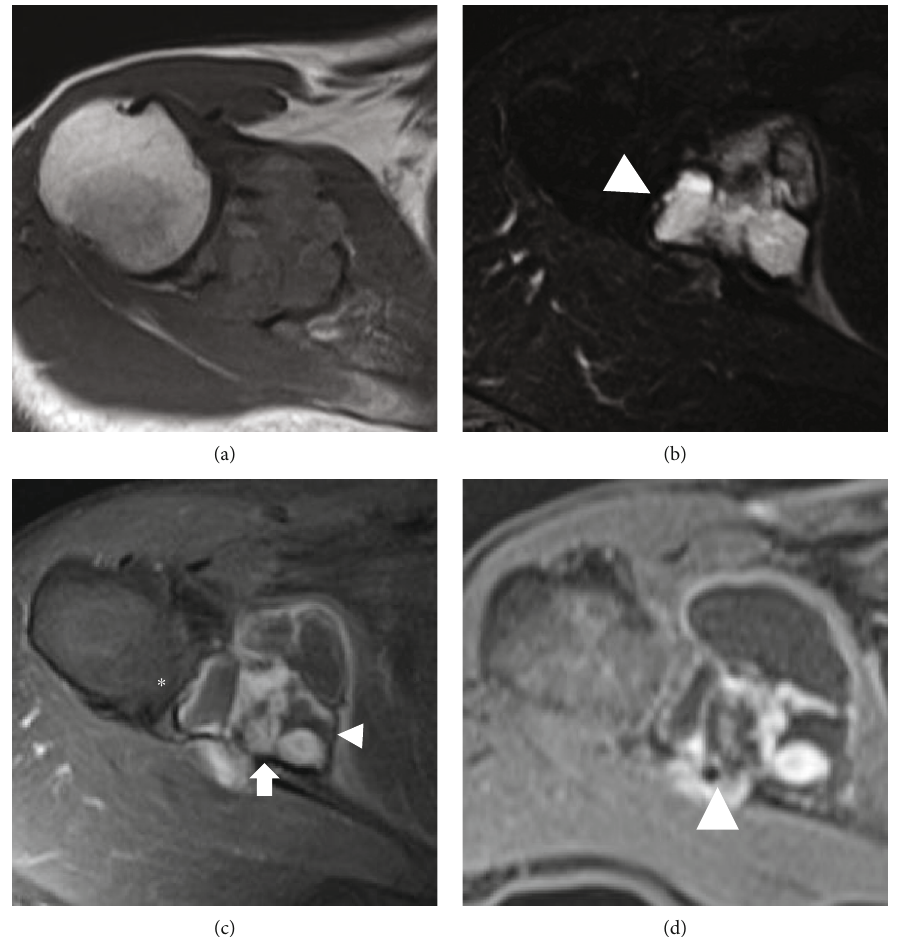
Figure 2: Magnetic resonance imaging at fi rst presentation (a) – (c), and postchemotherapy (d). The lobulated tumor is located at the scapula and is seen invading into the anterior and posterior soft tissue. (a) Axial T1-weighted image shows slightly high signal intensity. (b) Axial T2-weighted image depicts high signal intensity-multilocular mass with low signal intensity rim, and a part of the nodule shows fl uid- fl uid level (white arrowhead). (c) Axial Gd enhanced T1-weighted image represents thin enhancement surrounding low-intensity rim and enhanced solid nodule (arrow). Partial invasion into soft tissue is observed (asterisk). (d) Axial Gd enhanced T1-weighted image after chemotherapy shows cystic change of solid nodule compared with prechemotherapy image in (c)